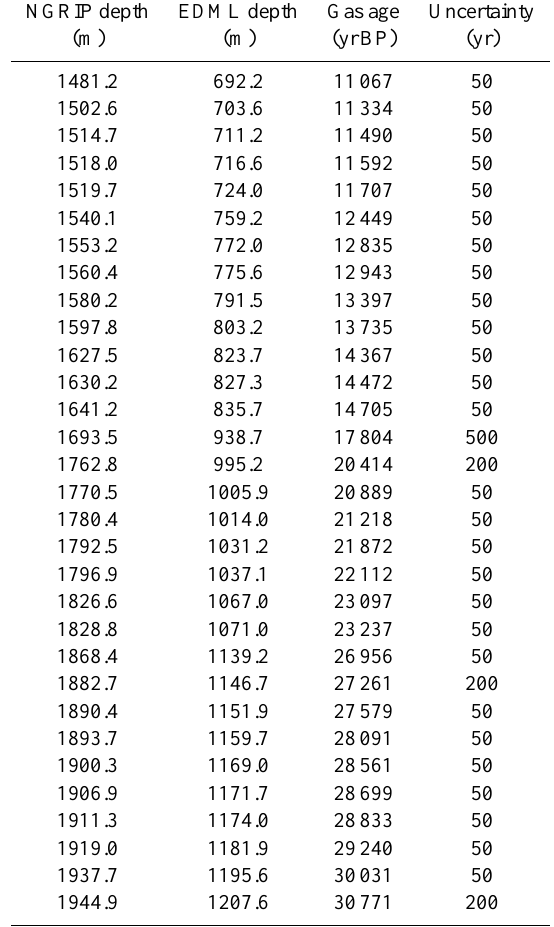
Table A1. List of tie points for CH 4 synchronisation of NGRIP to unified EDML gas age scale (Lemieux-Dudon et al.,